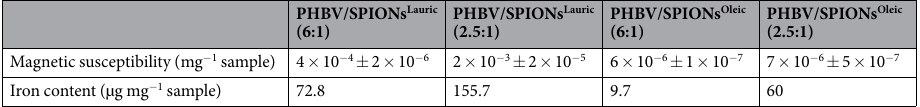
Table 2. Magnetic susceptibility and iron content, µ g mg − 1 in PHBV/SPIONs Lauric (6:1), PHBV/SPIONs Lauric (2.5:1), PHBV/SPIONs Oleic (6:1) and PHBV/SPIONs Oleic